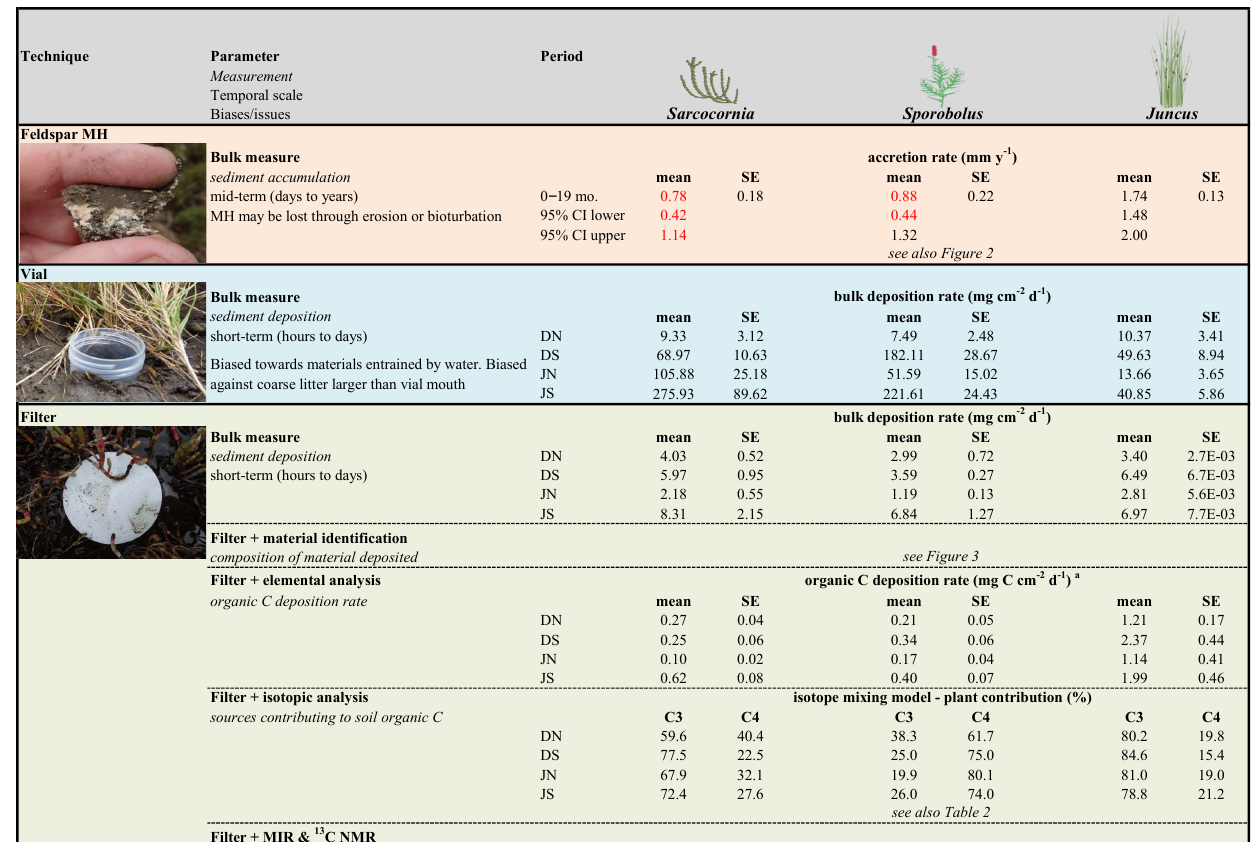
Table 1. Summary of sedimentation measurement techniques; mean and standard error values for feldspar marker horizon (MH), vial and filter bulk sediment measures; mean and standard error of organic C deposition rates; and contributions of C3 and C4 vegetation to depo- sition among vegetation assemblages. Accretion rates slower than local sea-level rise (1.15mmyr − 1 ) are in red. DN: December neap; DS: